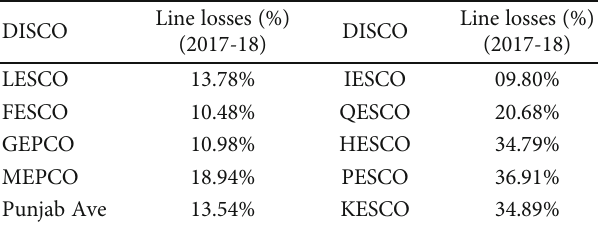
Table 1: Line losses of di ff erent DISCOs.